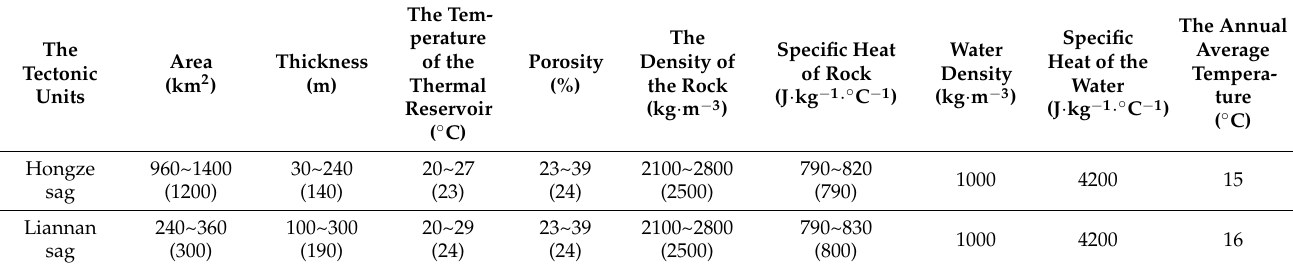
Table 2. Parameters for the Yancheng Formation thermal